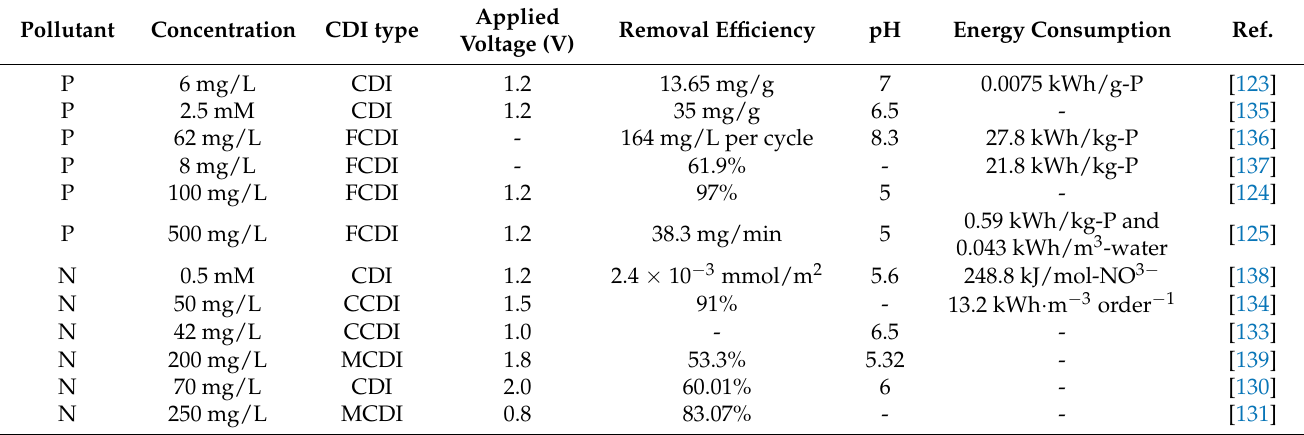
Table 3. Removal efficiency of phosphate and nitrate by CDI.